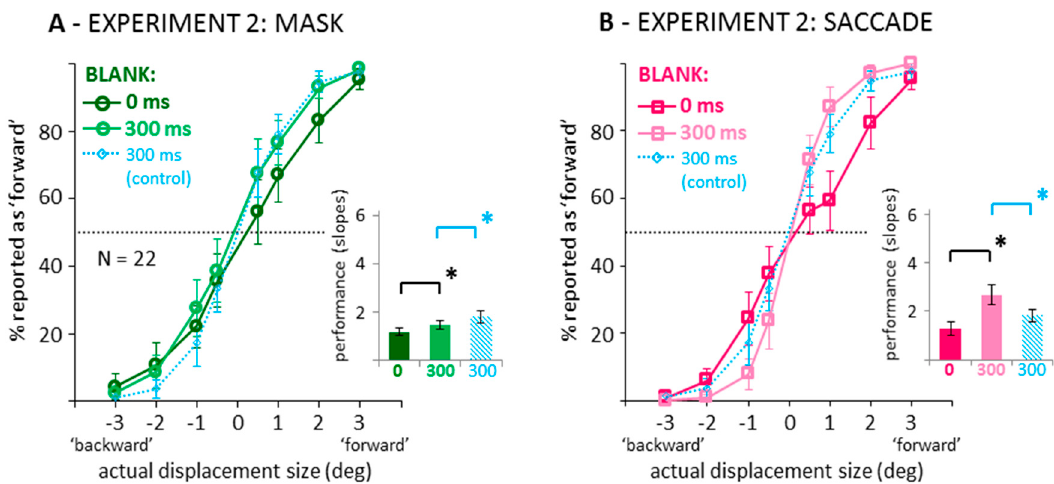
Figure 4. Data from the 0 and 300 ms blank conditions in the mask ( A ) and saccade ( B ) conditions of Experiment 2, recoded into binary displacement direction responses. Conventions as in Figure 2. Thin blue lines and striped blue bars represent data from an additional experiment (see Appendix B) with a 300 ms blank during fixation condition without mask.